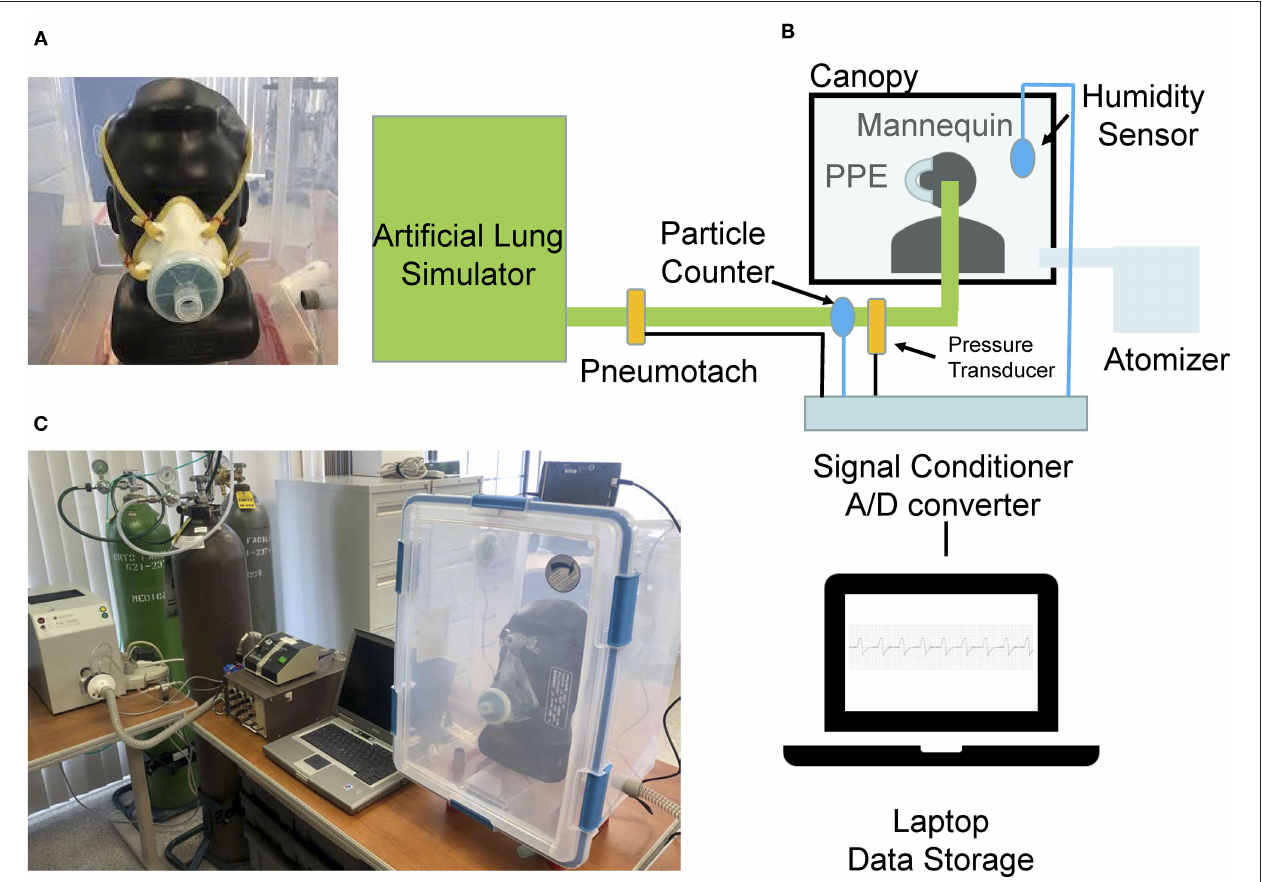
FIGURE 1 | Images of the (A) N99 mask with elastomeric lining and (B) bench experiment set-up. (C) A picture of the experiment set-up. Image of a N95 respiratory that was snugly fit on mannequin